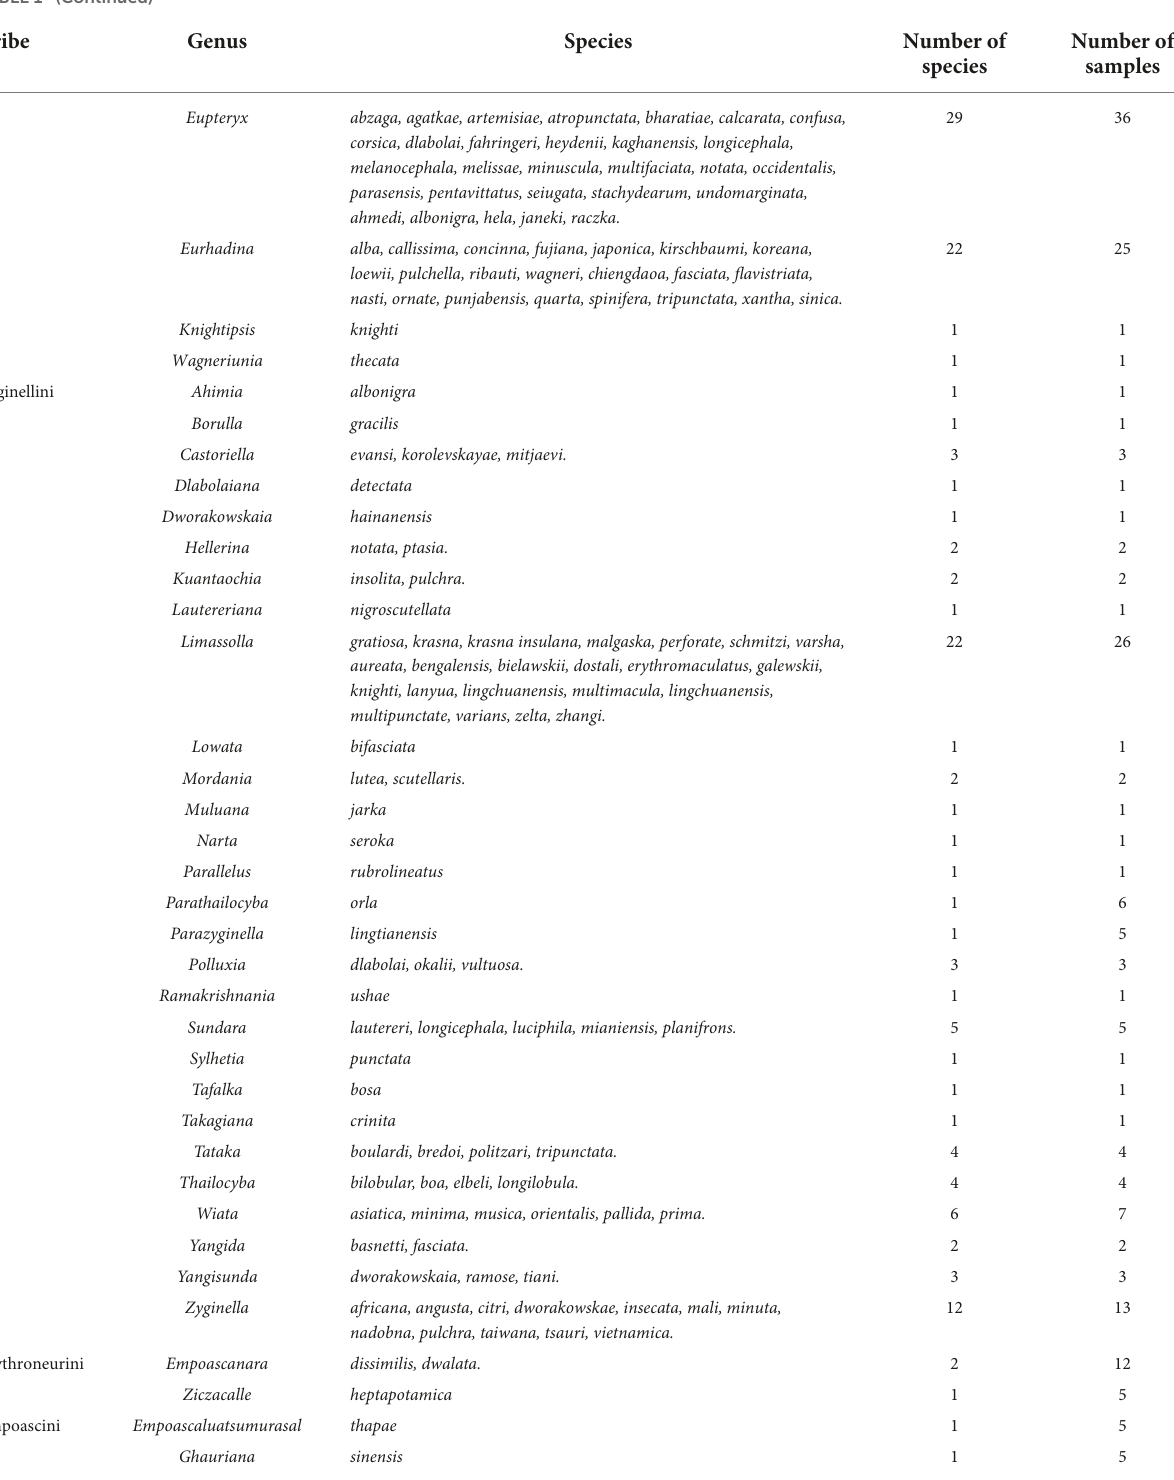
transverse vein is present, we marked both ends of the veins; where the transverse vein is absent, we marked two points at the point of fusion of the veins (respectively: light blue dots